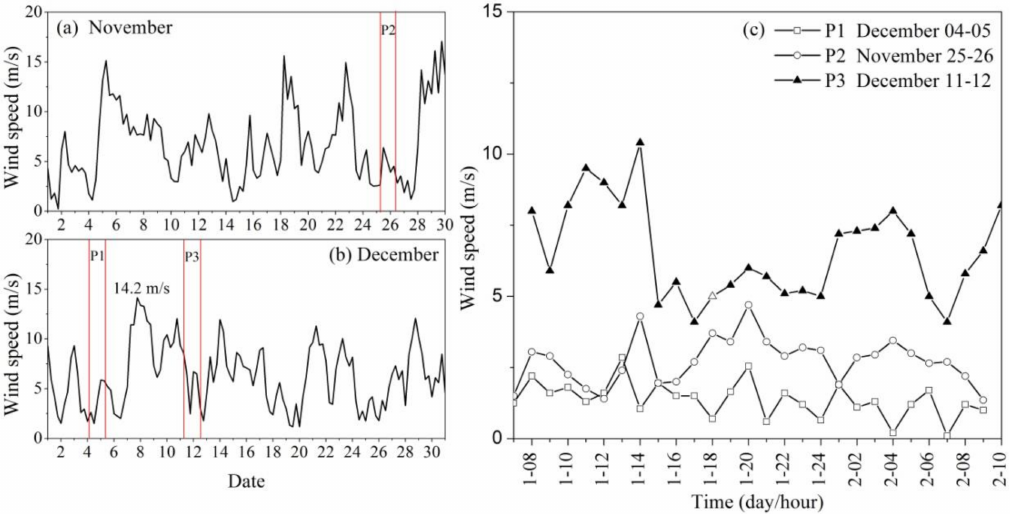
Figure 3. Time series of wind speed coming from NCEP around the Yellow River Estuary in: ( a ) November 2011; and ( b ) December 2011. ( c ) Time series of in-situ wind speed during the observation period at Stations P1 (open squares, N = 27), P2 (open circles, N = 27) and P3 (solid triangles, N = 27). The red lines indicate the dates when measurements were taken. Wind speed at Station P3 was higher than that at Stations P1 and P2, with the maximum wind speed up to 10.4 m/s. Strong winds occurred on 7 and 10 December before observation, with the highest wind speeds of approximately 14.2 m/s and 12.0 m/s,